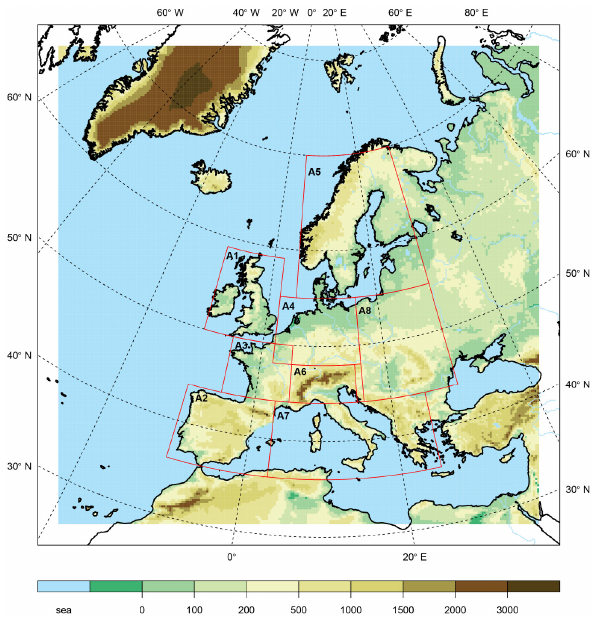
Figure 1. Orography [m] of model domain of cpastDat2-CCLM (colored area). The white frame indicates the 10 pixel wide sponge zone. The red boxes define the borders of the eight European stan- dard evaluation domains defined by Rockel and Woth (2007).